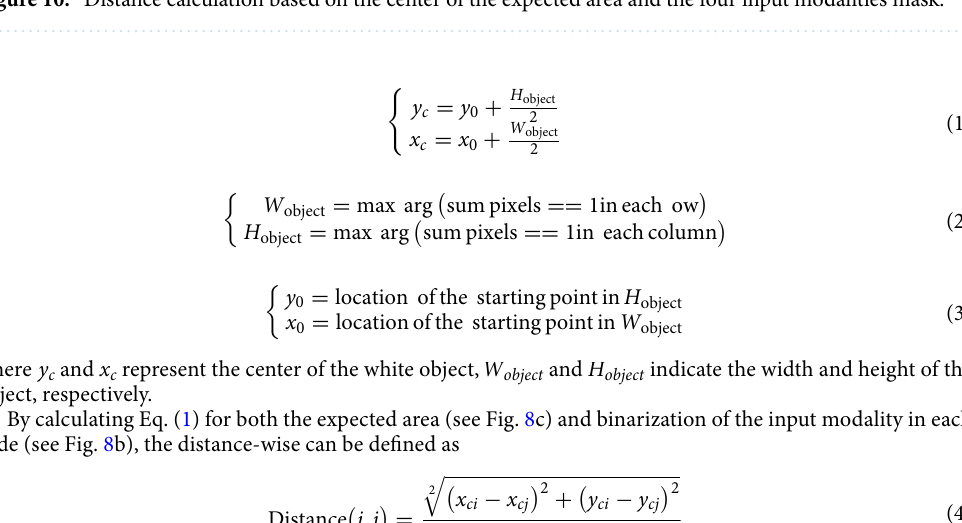
Figure 10. Distance calculation based on the center of the expected area and the four input modalities